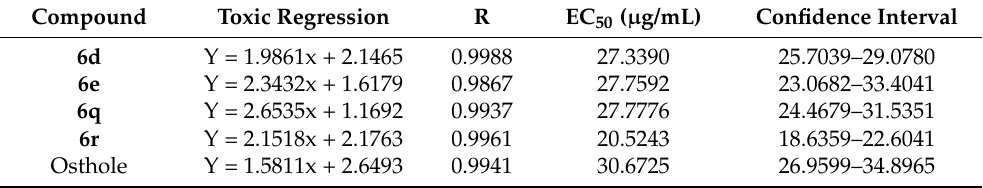
Table 4. EC 50 value determination of some target compounds against B. cinerea .